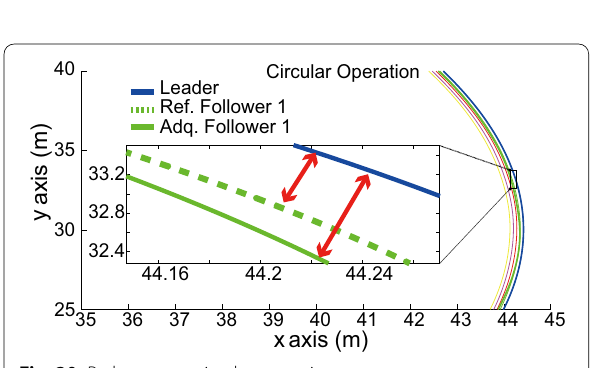
Fig. 20 Path error on circular operation